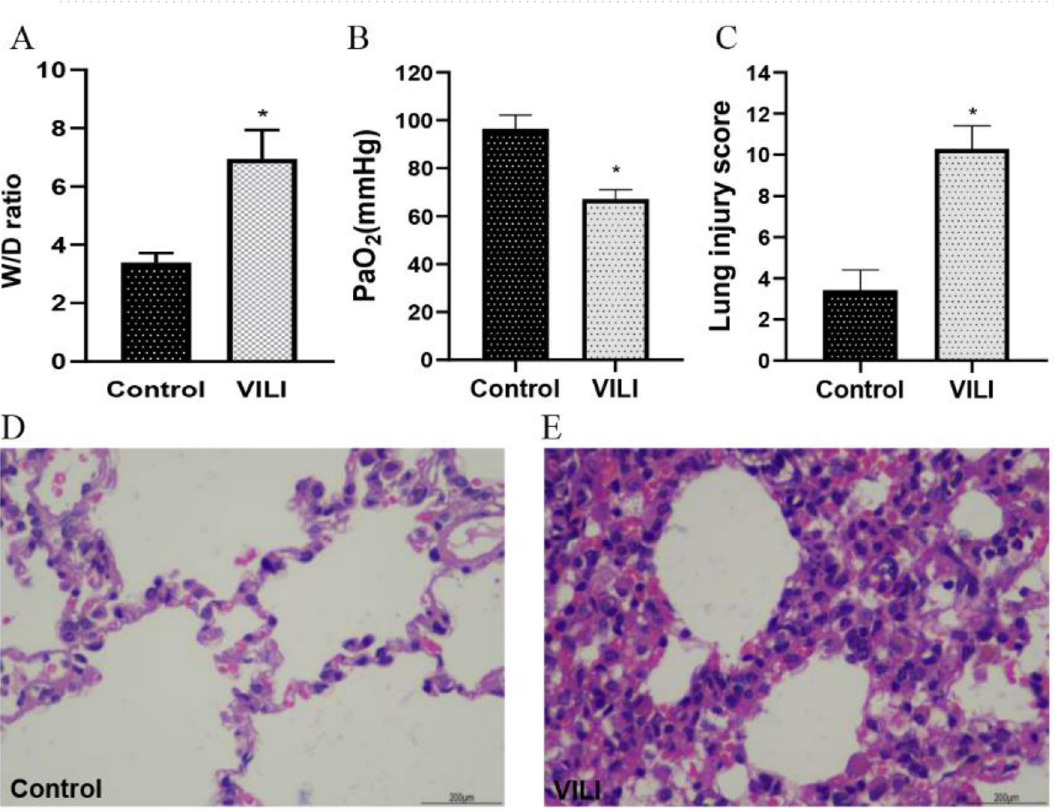
Figure 2. Characterization of VILI rats. ( A ) Lung W/D ratios, ( B ) Arterial oxygen level (PaO2) in blood gas analysis, ( C ) Lung injury scores, ( D ) H&E staining of lung tissue samples from the control group, ( E ) H&E staining of lung tissue samples from the VILI group. *p <